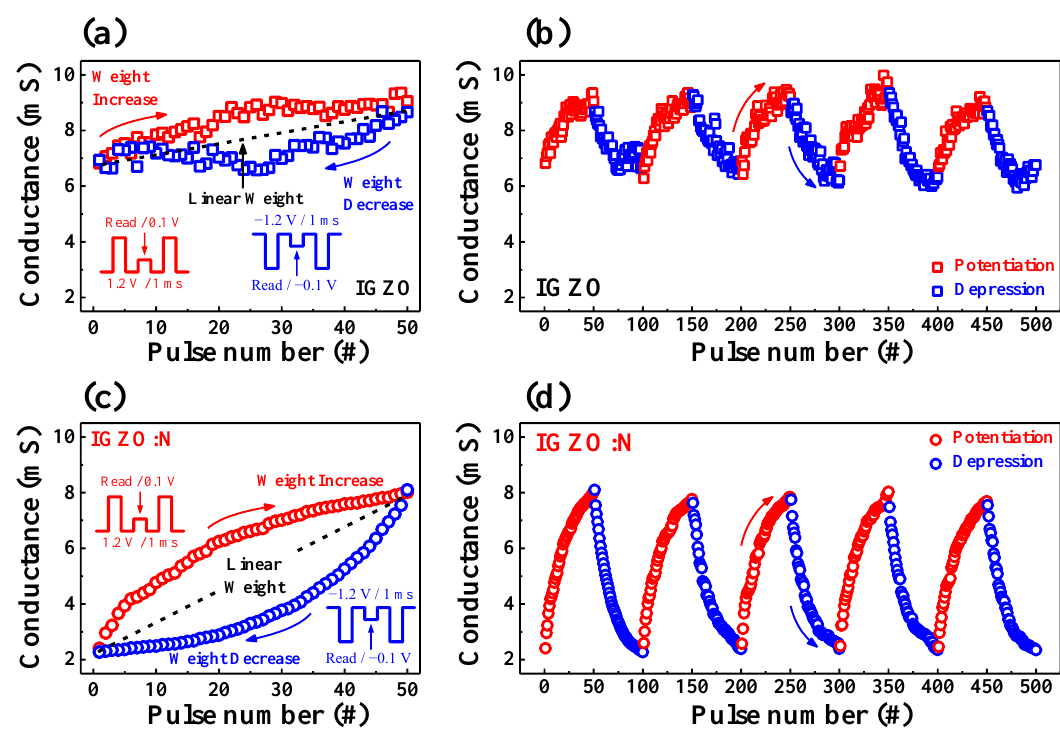
Figure 9. Synaptic weight potentiation/depression for ( a , b ) IGZO and ( c , d ) IGZO:N memristor devices: ( a , c ) Conductance increase and decrease characteristics during one electrical pulse stimulation cycle. ( b , d ) Weight modulation stability during five consecutive stimulus cycles (total of 5 × 10 2 synaptic pulses).